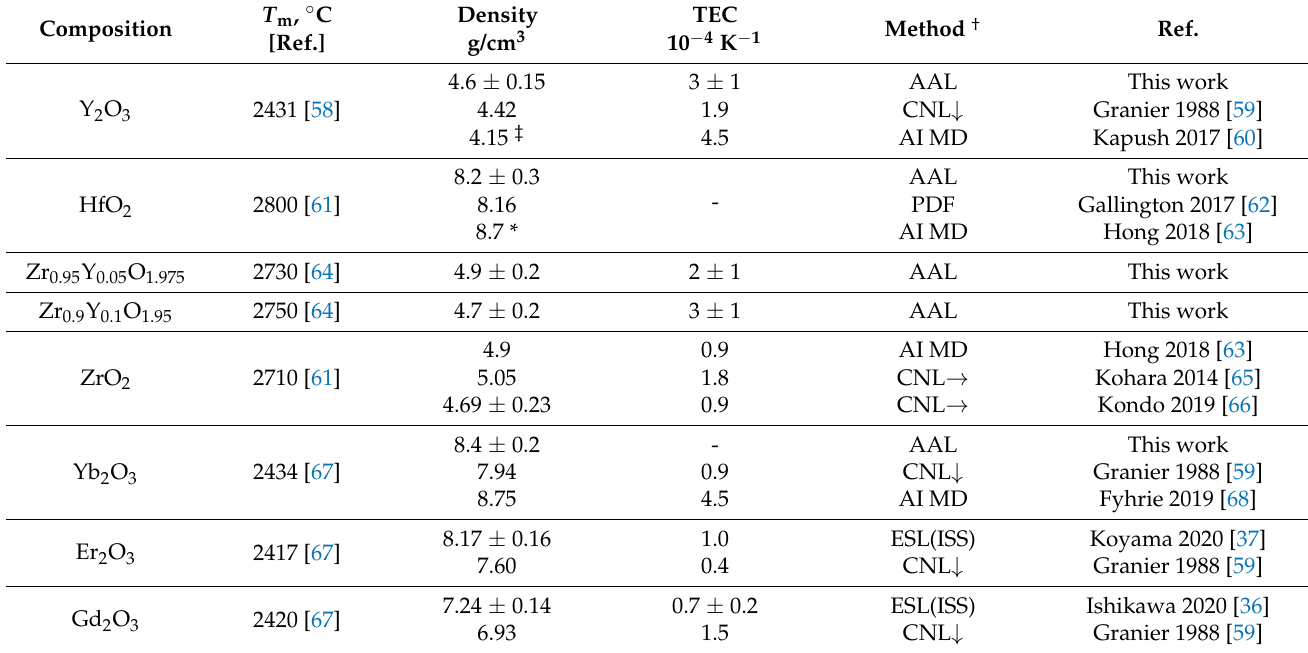
Table 1. Density and volumetric thermal expansion coefficient (TEC) for liquid oxides at melting temperatures ( T m ) measured in this work compared with previously published